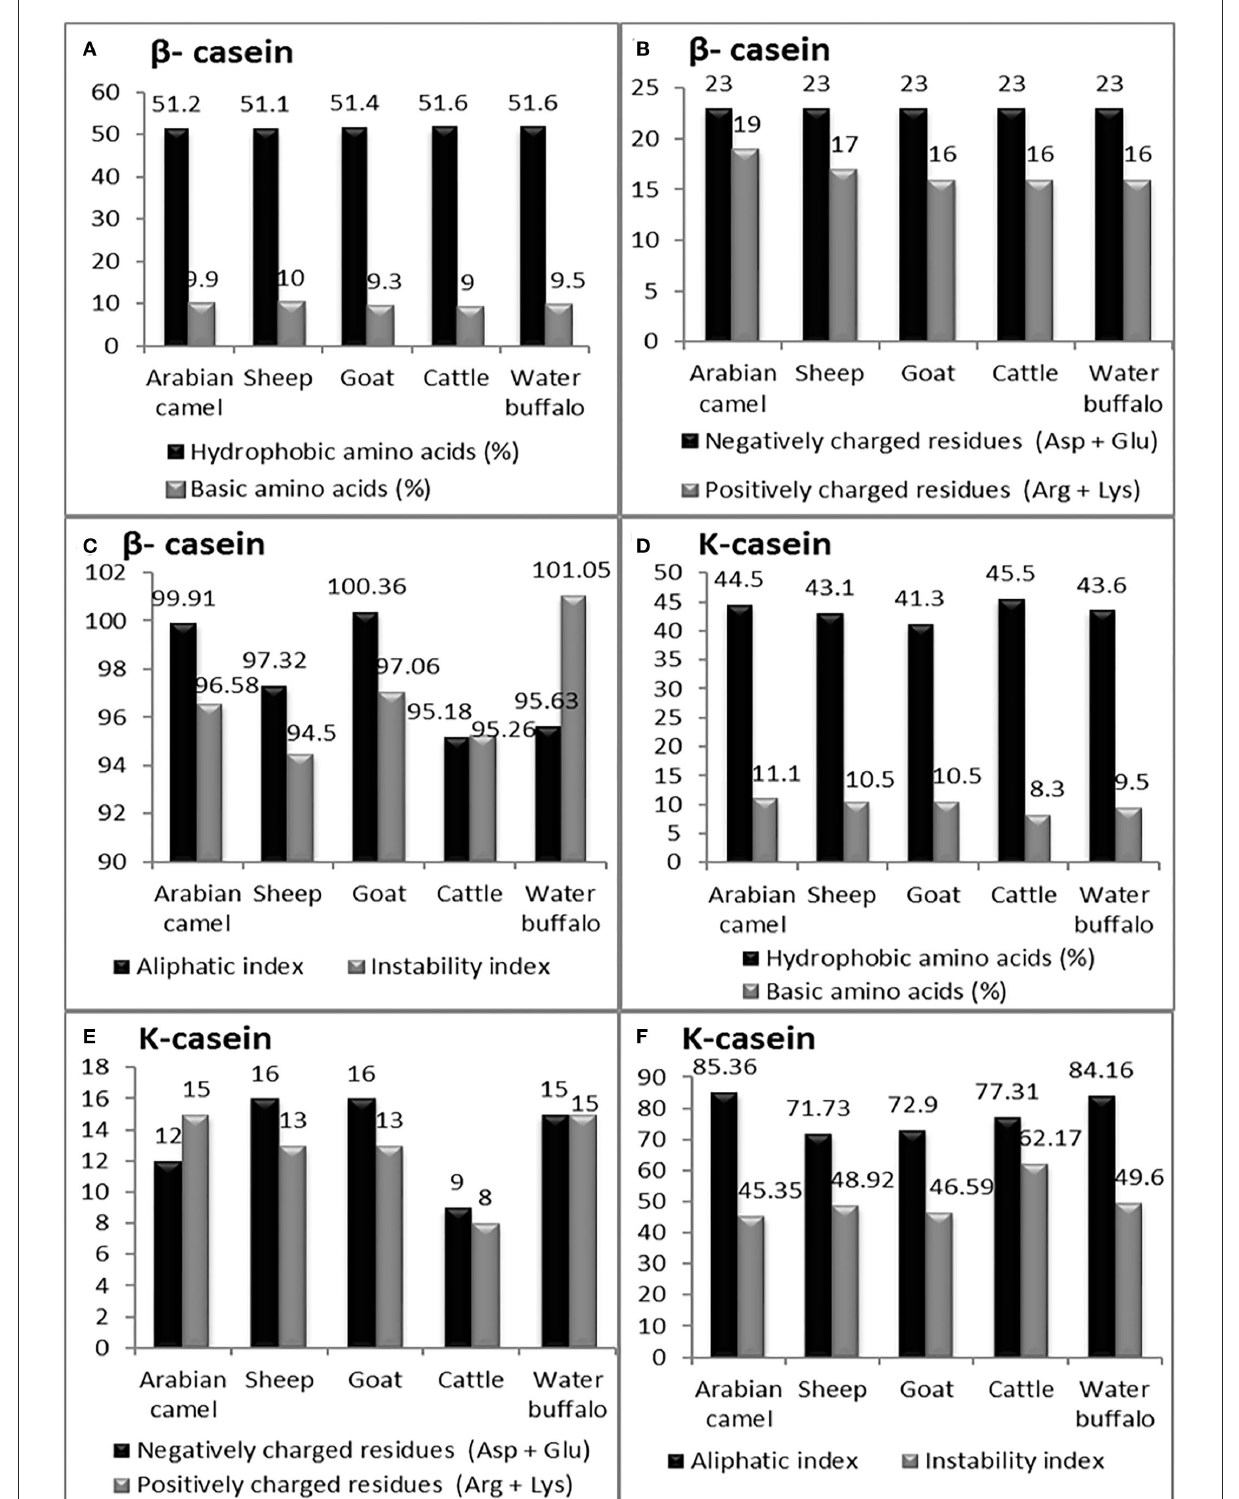
FIGURE6 The computed parameters of β -casein; (A) Hydrophobic amino acids (%), Basic amino acids (%). (B) Negatively charged residues (Asp + Glu), positively charged residues (Arg + Lys). (C) Aliphatic and instability indexes. The computed parameters of K-casein. (D) Hydrophobic amino acids (%), Basic amino acids (%). (E) Negatively charged residues (Asp + Glu), positively charged residues (Arg + Lys). (F) Aliphatic and instability